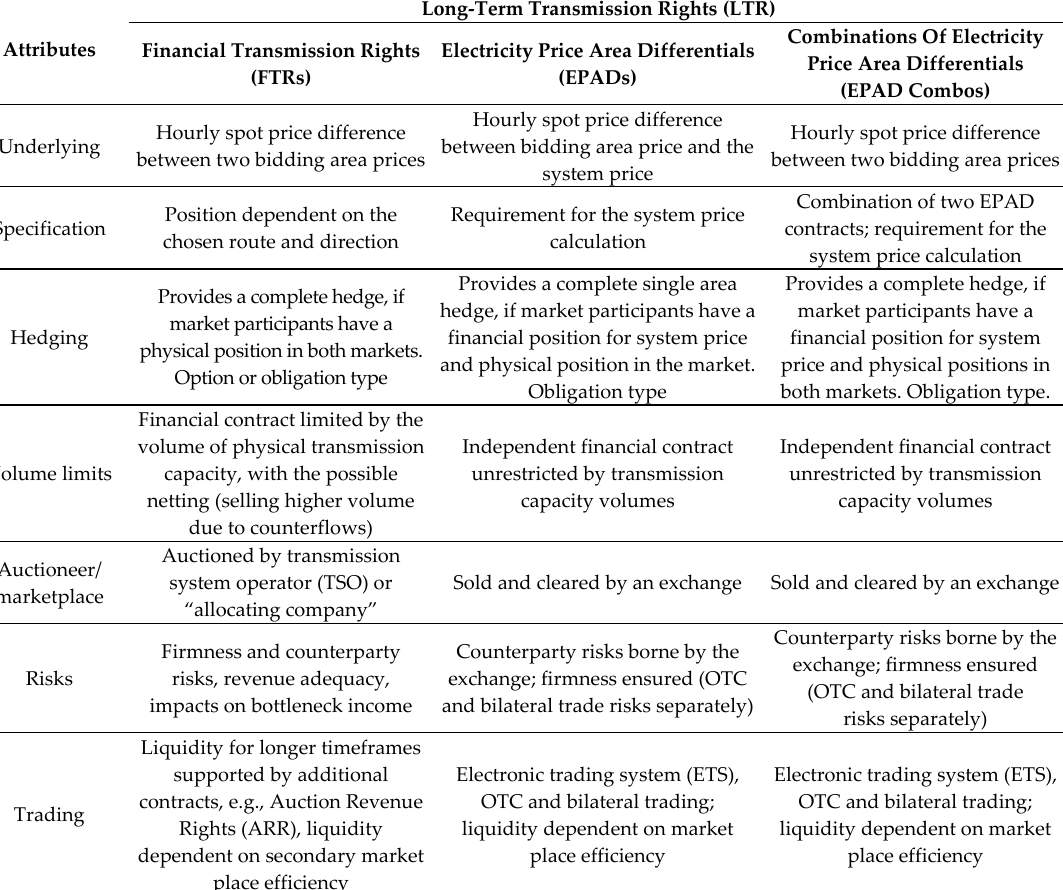
Table 1. Main characteristics of FTRs, EPADs, and EPAD